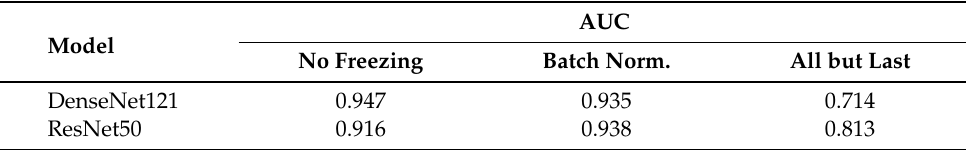
Table 3. Mean AUCs of the best global DenseNet121 and ResNet50 models, evaluated on the clients’ test sets. Batch norm. refers to freezing of batch normalization layers, All but last to freezing all parameters except for the final classification layer. Training with frozen batch normalization layers delivered similar results to full model training.